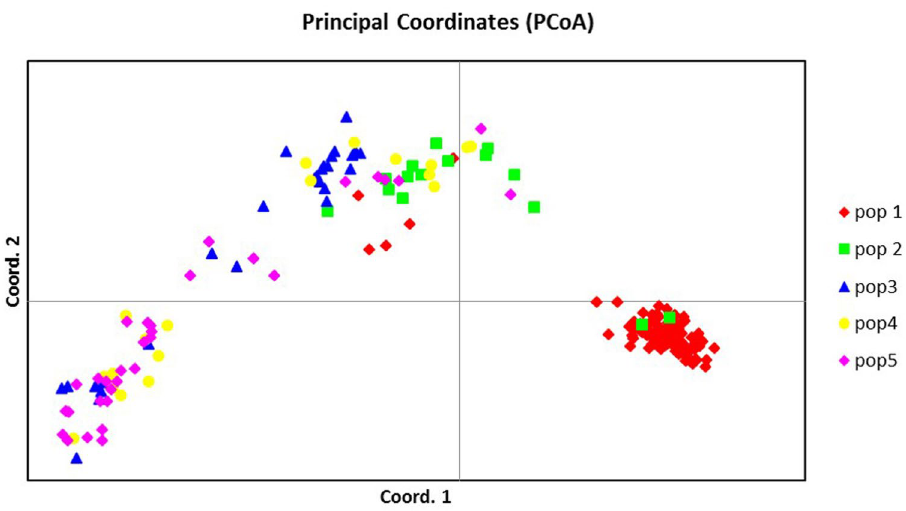
Figure 8. Principal coordinate analysis of the 190-clone sugarcane mini-core. Coordinate 1 = 14.24, Coordinate 2 = 3.87, Coordinate 3 = 1.97. Pop 1: Saccharum hybrids, Pop 2: S. officinarum , Pop 3: S. spontaneum ,